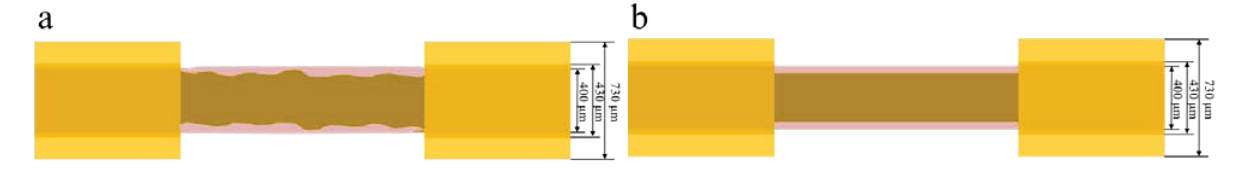
Figure 6. Schematic of optical fiber defects: ( a ) non-uniform changes in property; and ( b ) uniform changes in property.